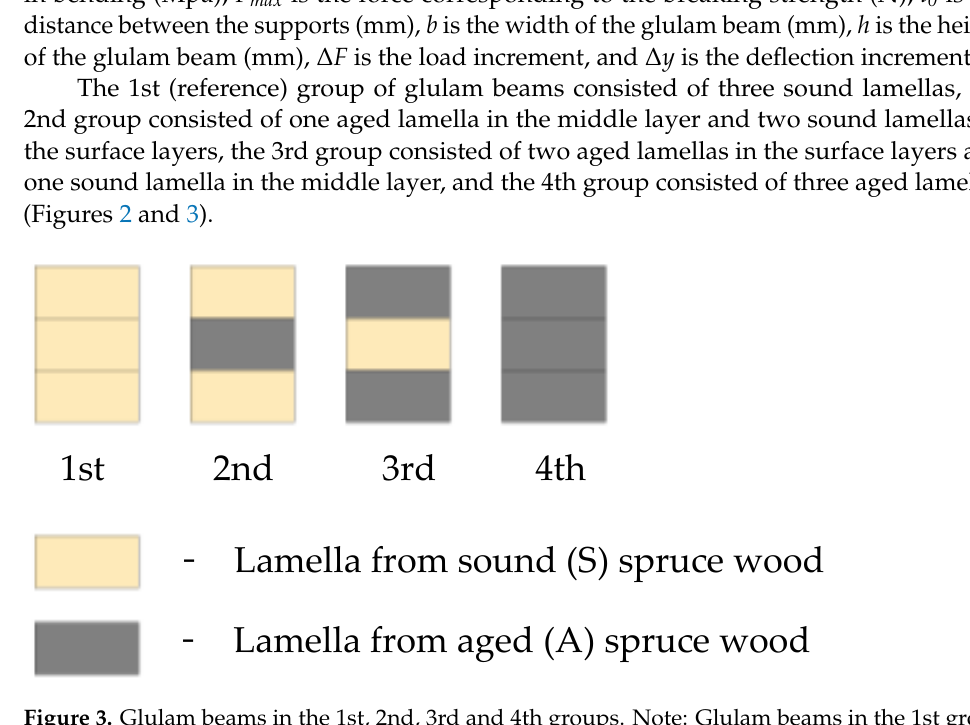
Figure 3. Glulam beams in the 1st, 2nd, 3rd and 4th groups. Note: Glulam beams in the 1st group consist of three sound “S” lamellas; those in the 2nd group consist of two sound “S” lamellas on surfaces and one aged “A” lamella in middle; those in the 3rd group consist of one sound “S” lamella in middle and two aged “A” lamellas on surfaces; and those in the 4th group consist of three aged “A” lamellas.